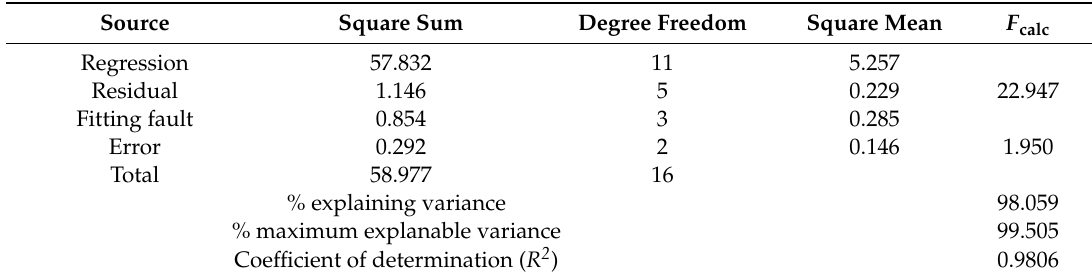
Table 5. Evaluation of model fit by variance analysis (ANOVA) at a 95% confidence level. Source Square